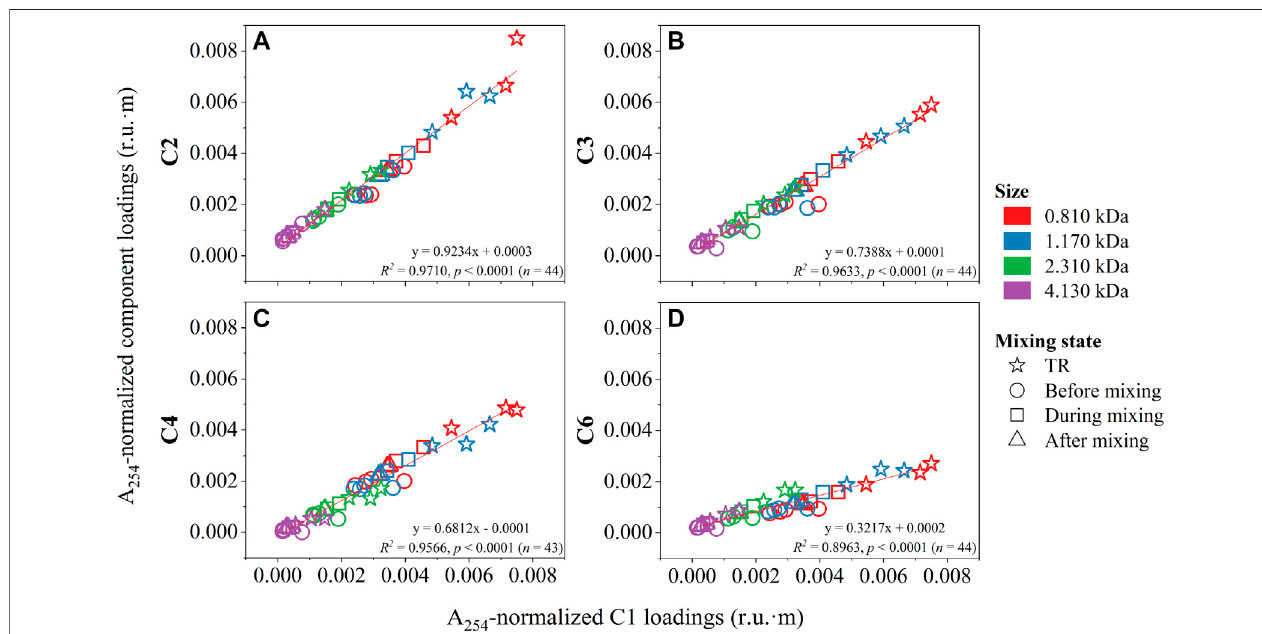
FIGURE 8 | Ratios of A 254 -normalized PARAFAC component loadings (r.u. · m) by C1 for other terrestrial humic-like components (C2 – C4, and C6) found in this study. TR denotes tributaries. Before, during, and after mixing refer to mixing states of the mainstem.